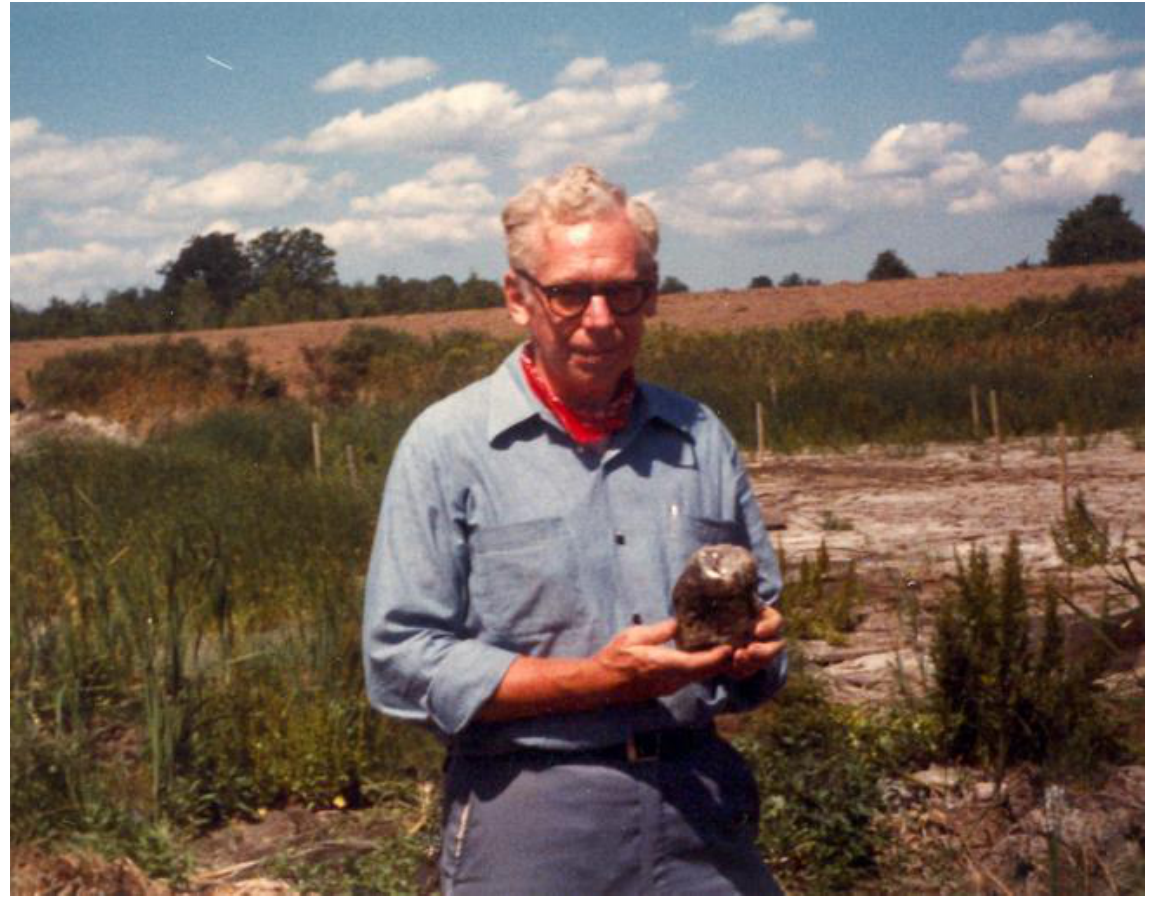
Figure 1. Jack Holland. (Photo by Jack